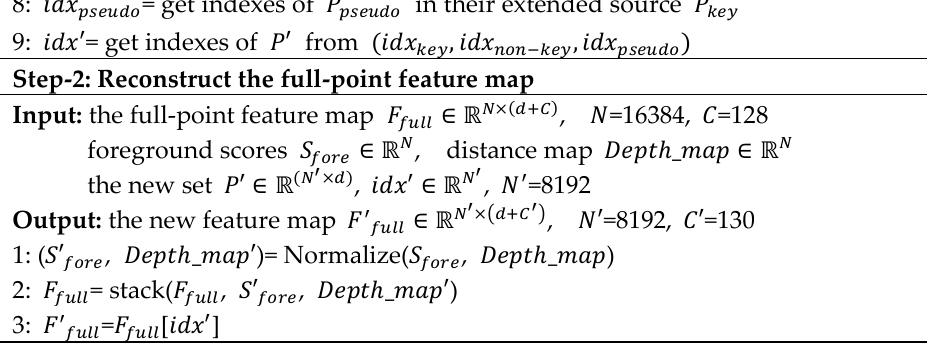
Figure 6. The pseudocode of the proposed sorting simplification strategy.